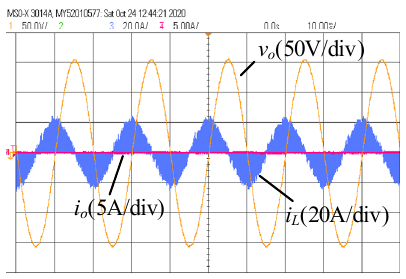
Figure 10. The voltage and current waveforms of the DCM inverter at P o = 0. Time: 10 ms/div.